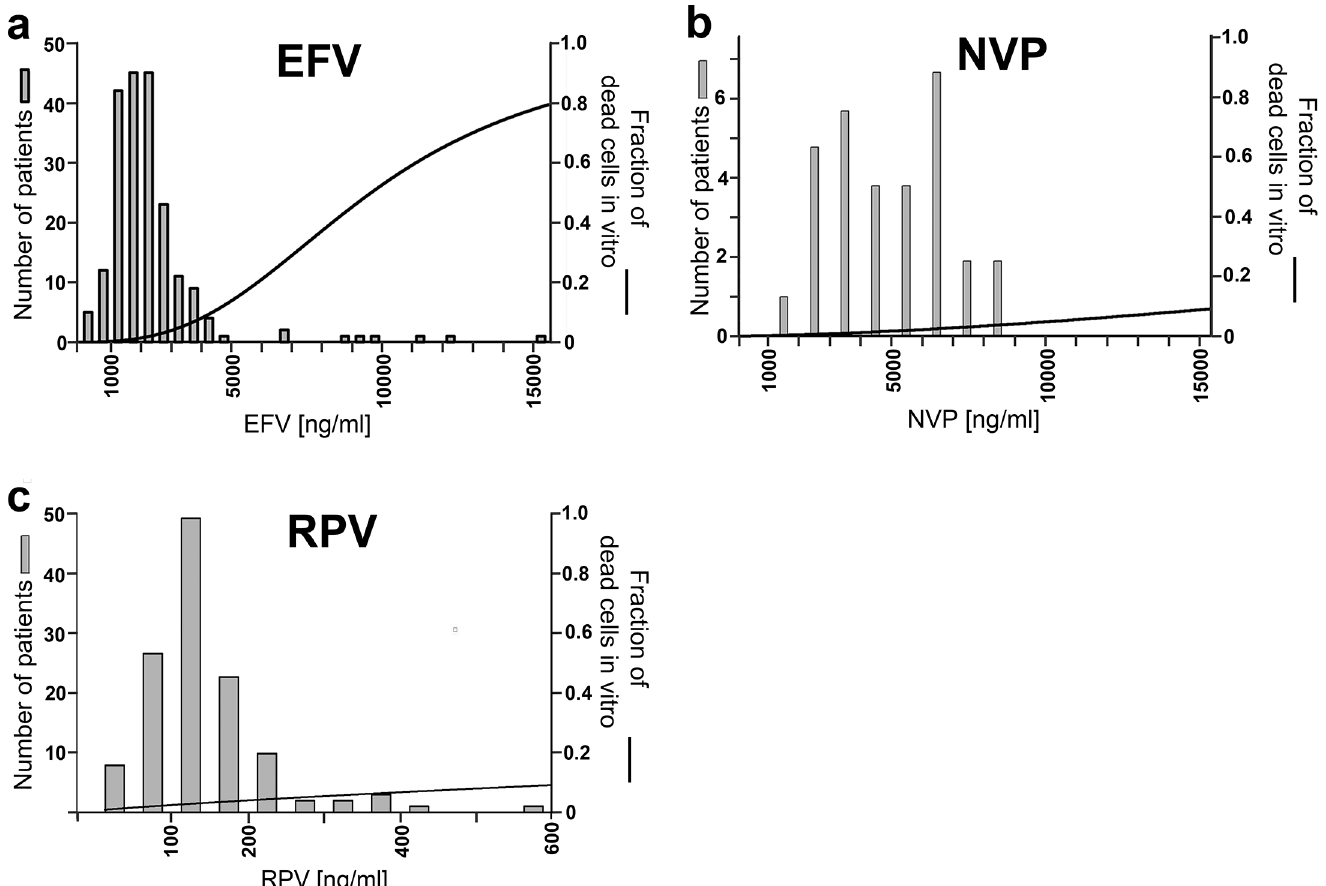
Fig 4. Comparison of blood levels in patients with in vitro toxic EC50 of EFV, NVP and RPV. Blood levels of (a) EFV, (b) NVP and (c) RPV determined by HPLC (bars). These in vivo concentrations are compared to the fitted function of the in vitro toxicity against BxPC-3 pancreatic cancer cells in the Annexin- V-APC/AAD staining (solid